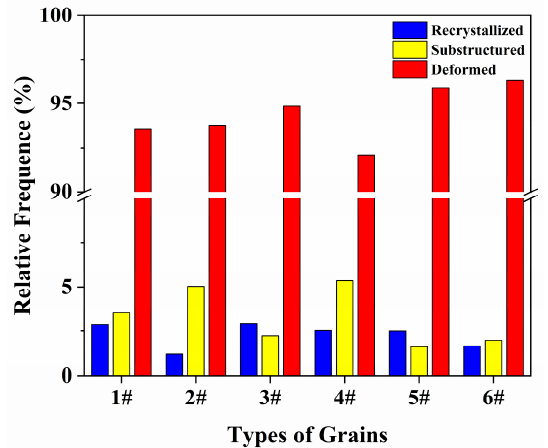
Figure 4. Percentage of recrystallization of cold rolled alloys.